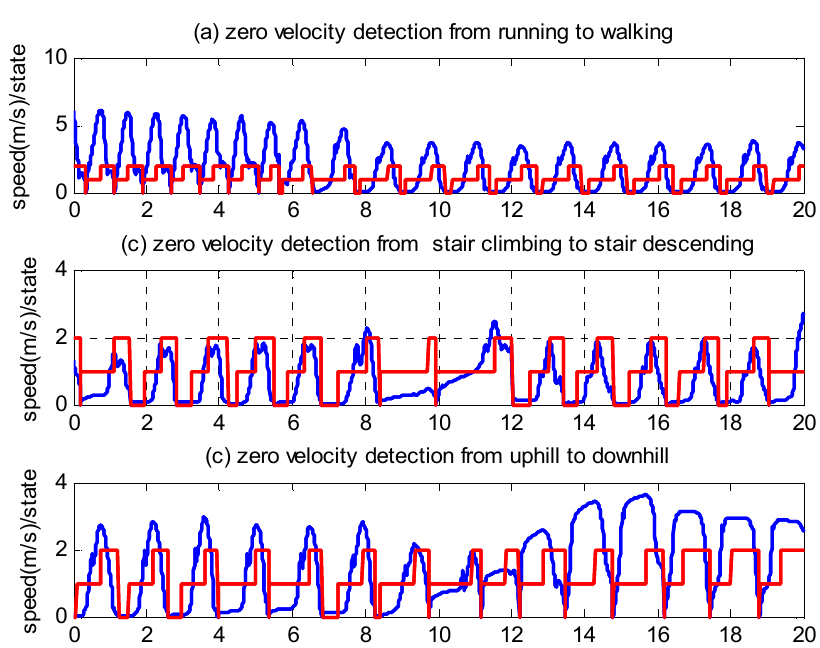
Figure 9. Zero velocity detection using method proposed in [11]. The vertical unite is dimensionless numbers.